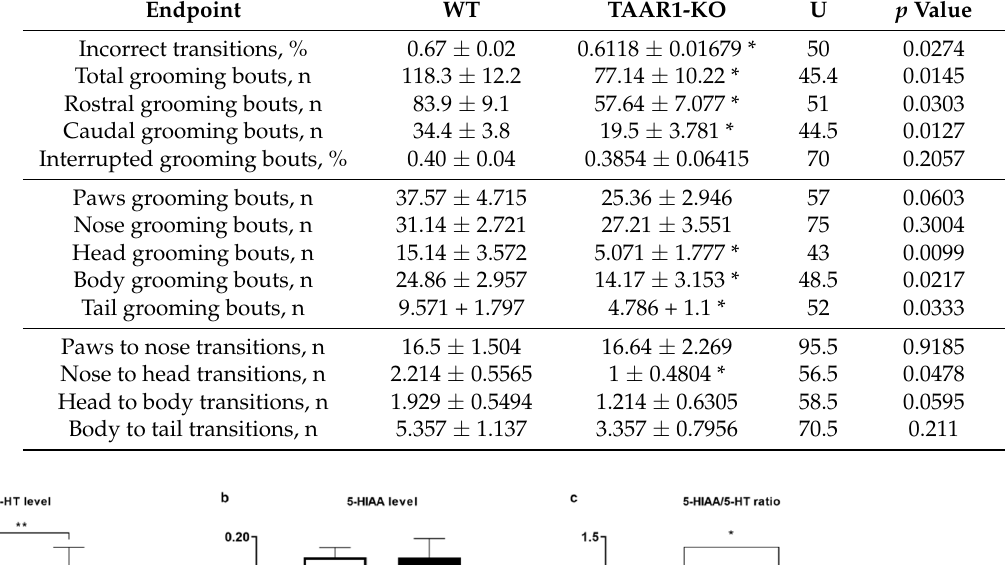
(Figure 5a; p = 0.0146). Other neurochemical parameters in different brain structures were unaffected (Supplementary Table S1). Table 1. Summary of statistical results of TAAR1 knockout (KO)-induced behavioral changes in mouse self-grooming test and self-grooming microstructure analysis. WT—wild type control mice. Data are presented as mean ± SEM (n = 14). * p < 0.05 vs. control, Mann–Whitney U-test.